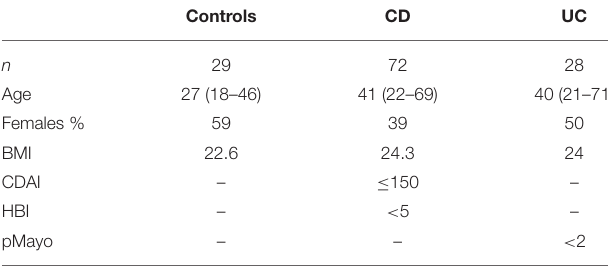
TABLE 1 | Characteristics of the study groups.